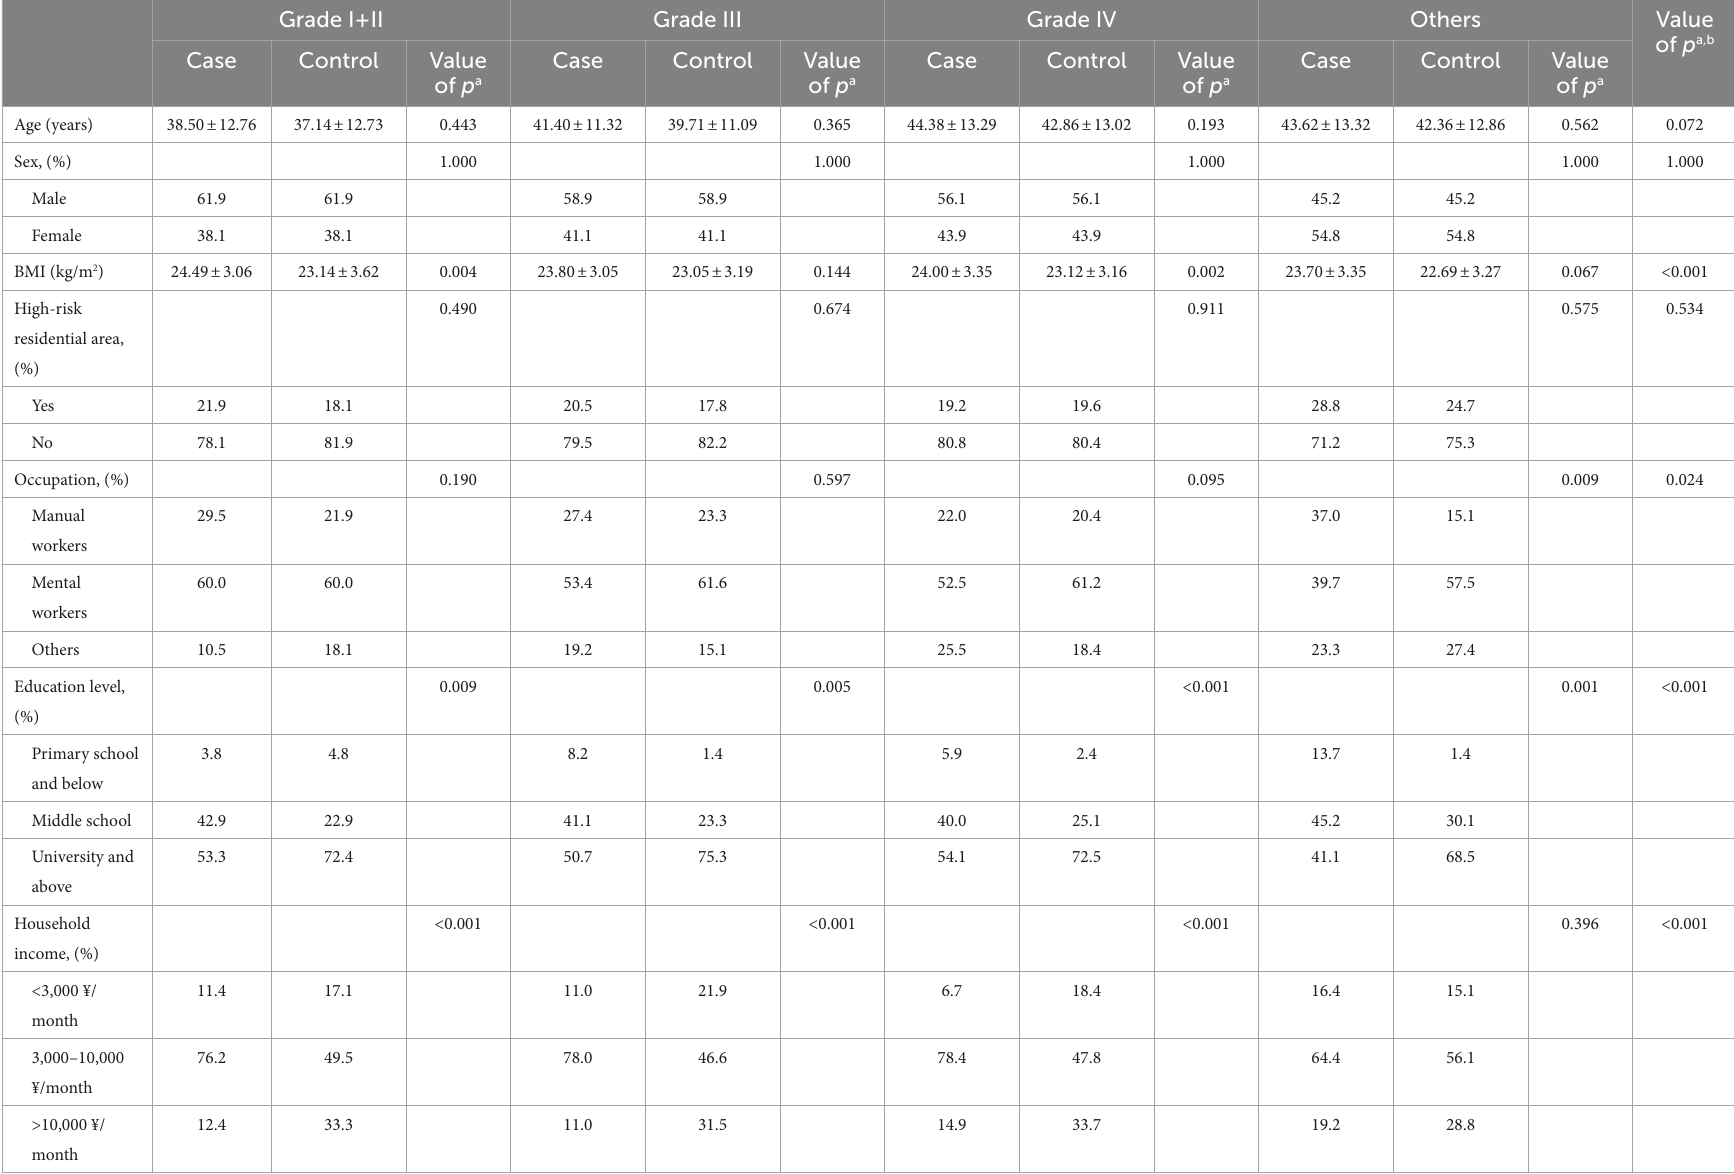
TABLE 1 Basic characteristics of the study participants.